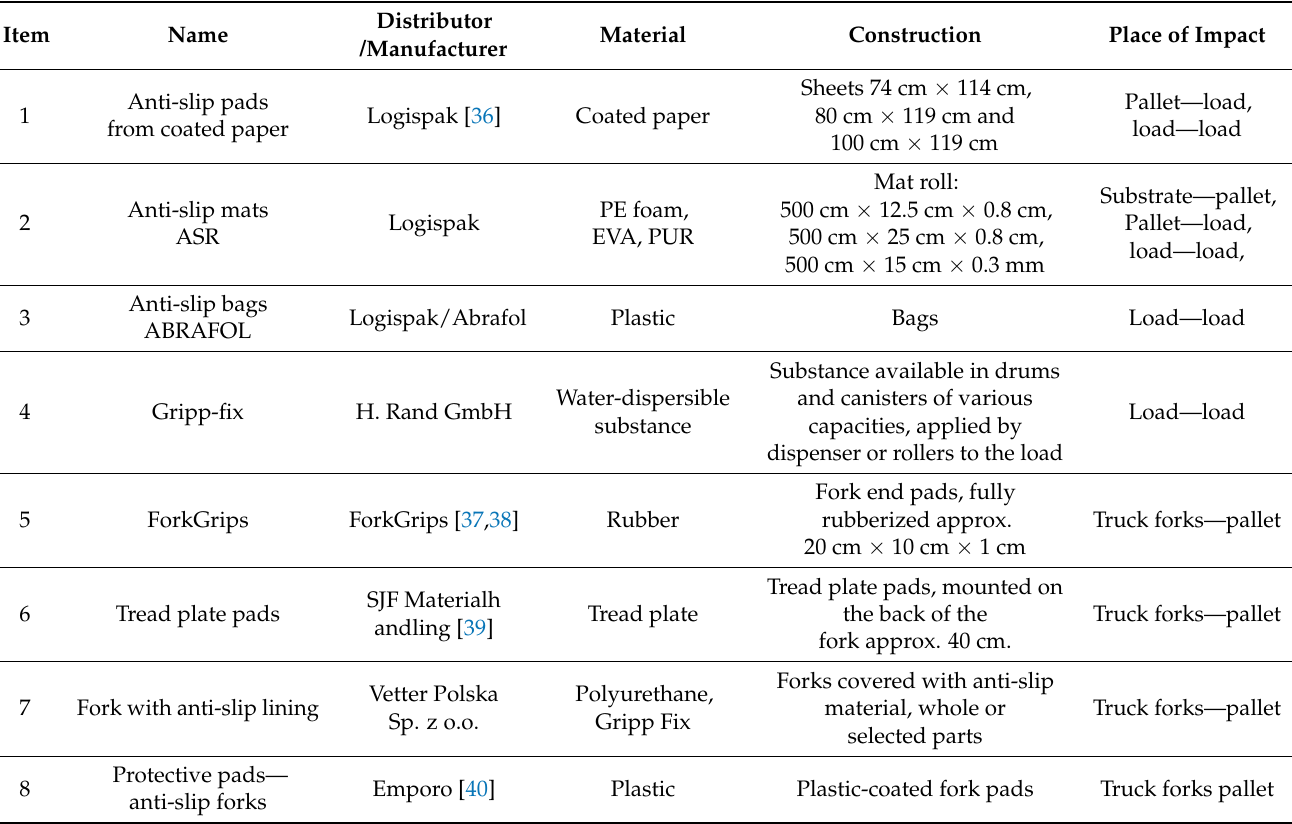
Table 1. Examples of material treading